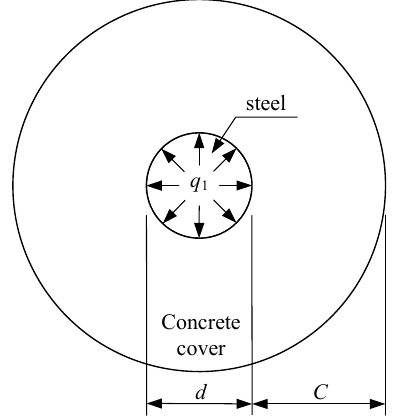
Figure 5. Thick-walled cylinder model.